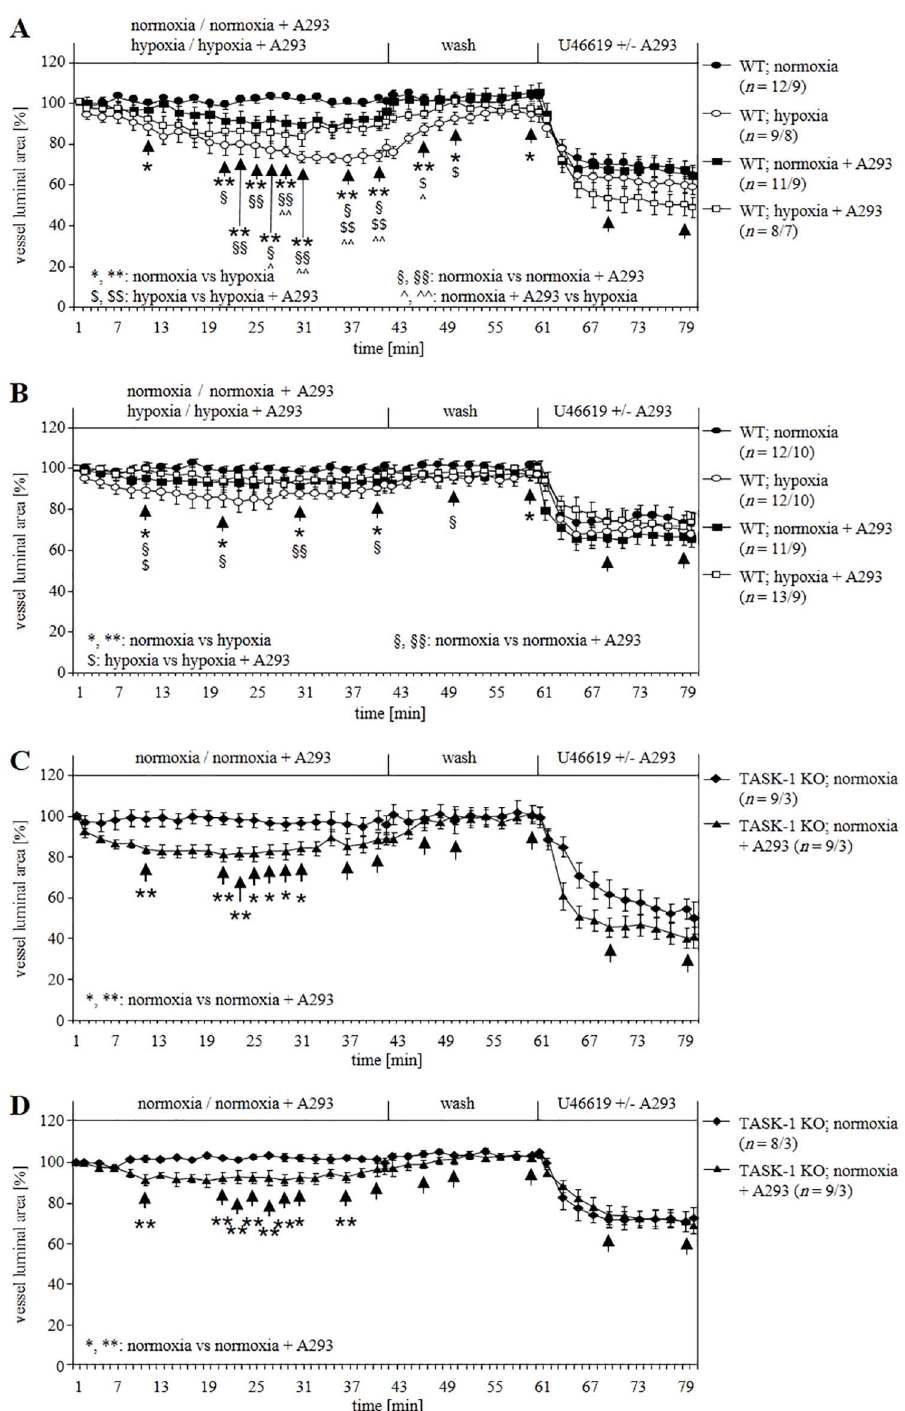
Fig 6. Impact of TASK-1 inhibitor A293 on vasoconstriction of WT and TASK-1 KO mice. A293 induced constrictionof WT intra- (A) and pre-acinar (B) arteries at normoxia and reducedhypoxia-induced vasoconstriction. In KO intra- (C) and pre-acinar (D) arteries at normoxia, the constrictory effect of A293 persisted. Data are presentedas mean ± SEM. n is number of vessels/number of animals. Tests of significancewere done at the time points indicatedby arrows. * , #, §, $ P (cid:20) 0.05 and ** , ##, §§, $ $ P (cid:20) 0.01 (Mann–Whitney U-test).